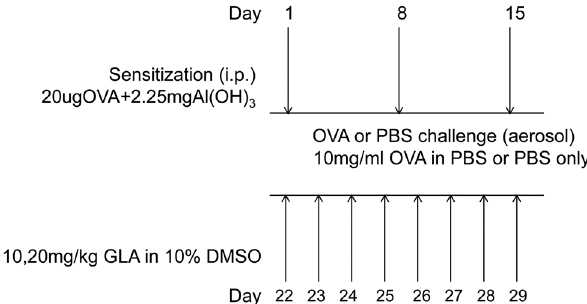
Figure 2: Flow chart for the establishment of mouse asthma model ( N = 8 )